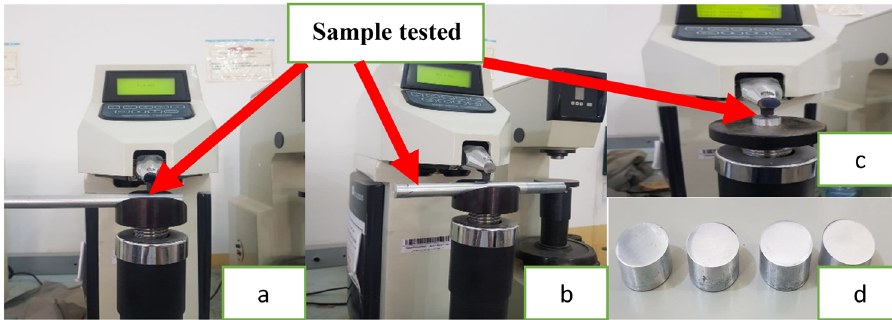
Figure 9: Rockwell hardness and samples tested: ( a ) circumference hardness ( front view ) ; ( b ) isometric view; ( c ) core hardness; and ( d ) core